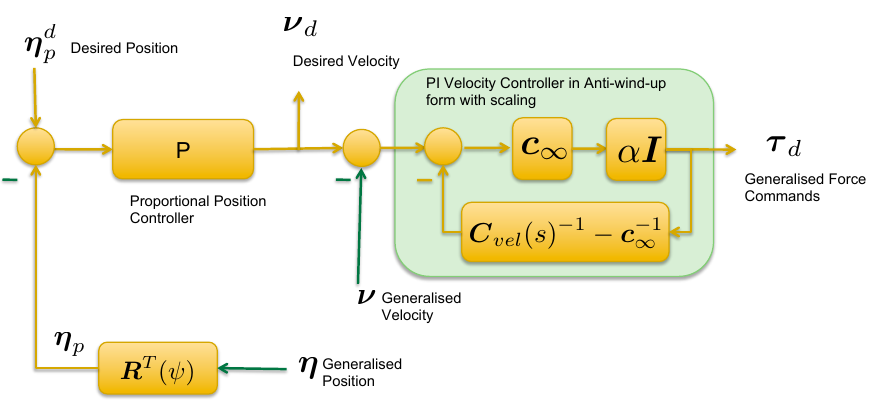
Figure 4: Vehicle positioning controller with velocity loop in anti-windup form with